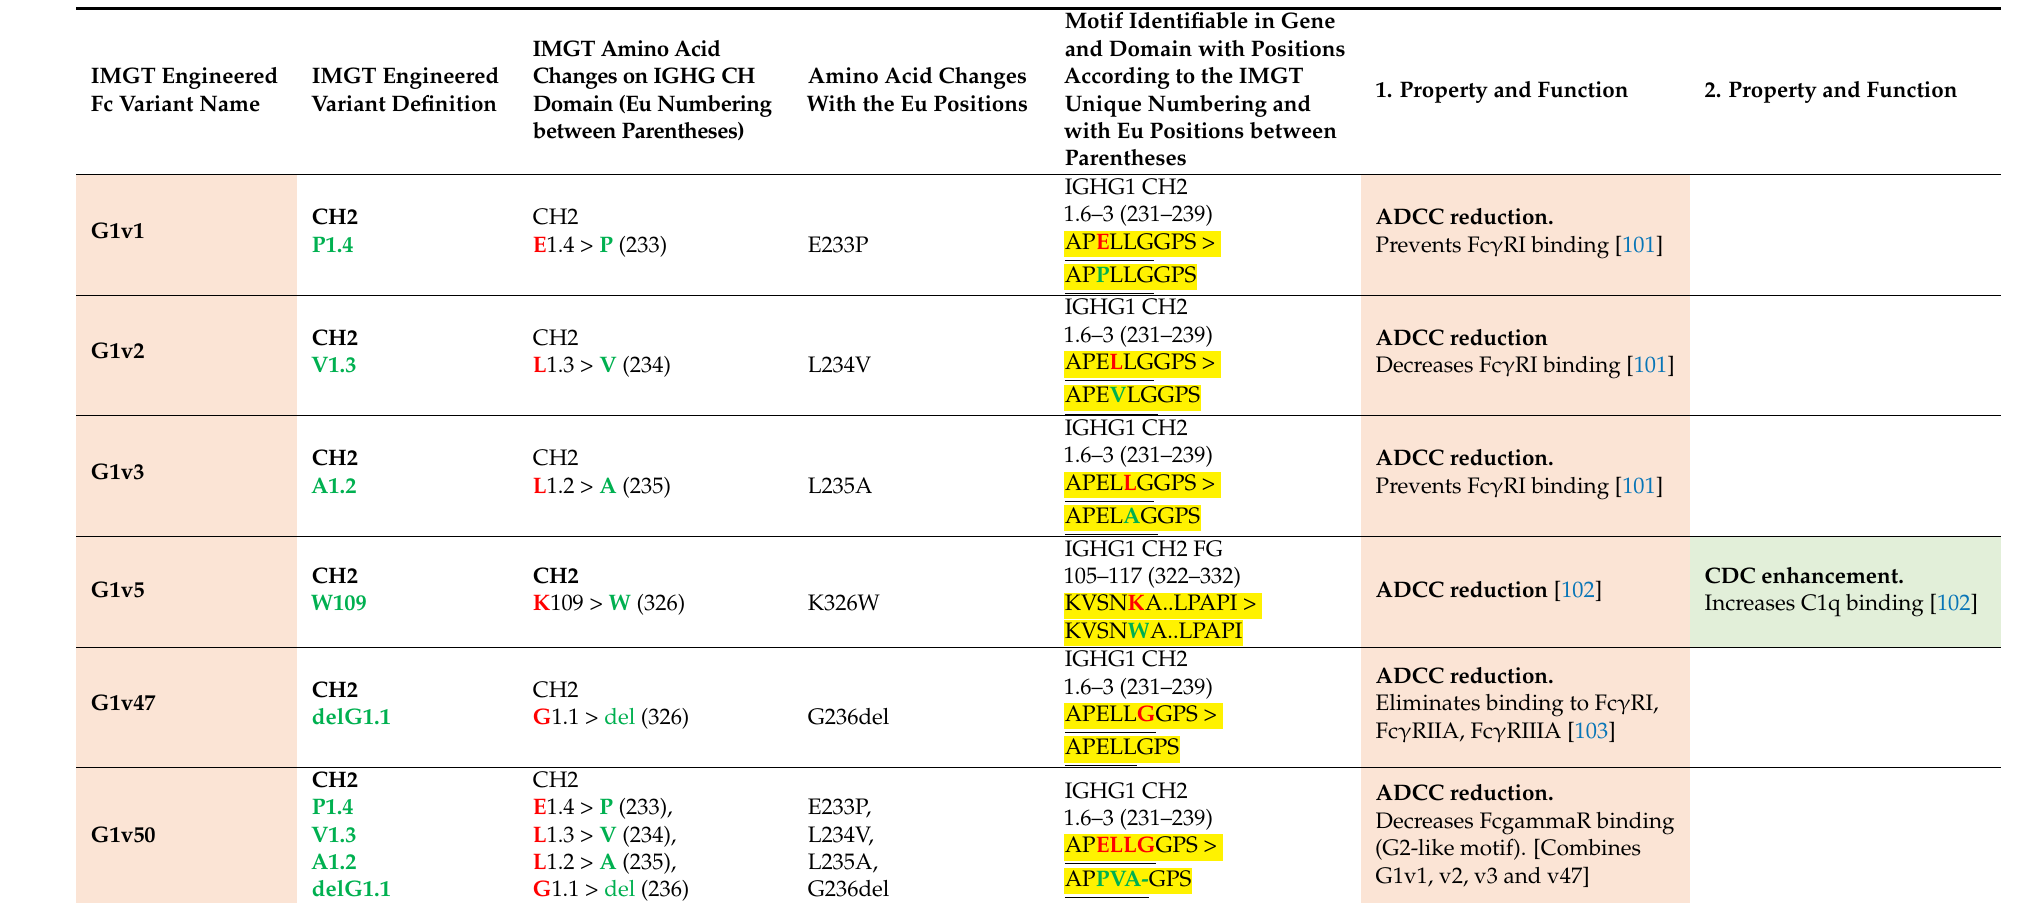
Table 5. IMGT nomenclature, Eu positions and IMGT motif of engineered Fc variants involved in antibody-dependent cellular cytotoxicity (ADCC) reduction (Effector